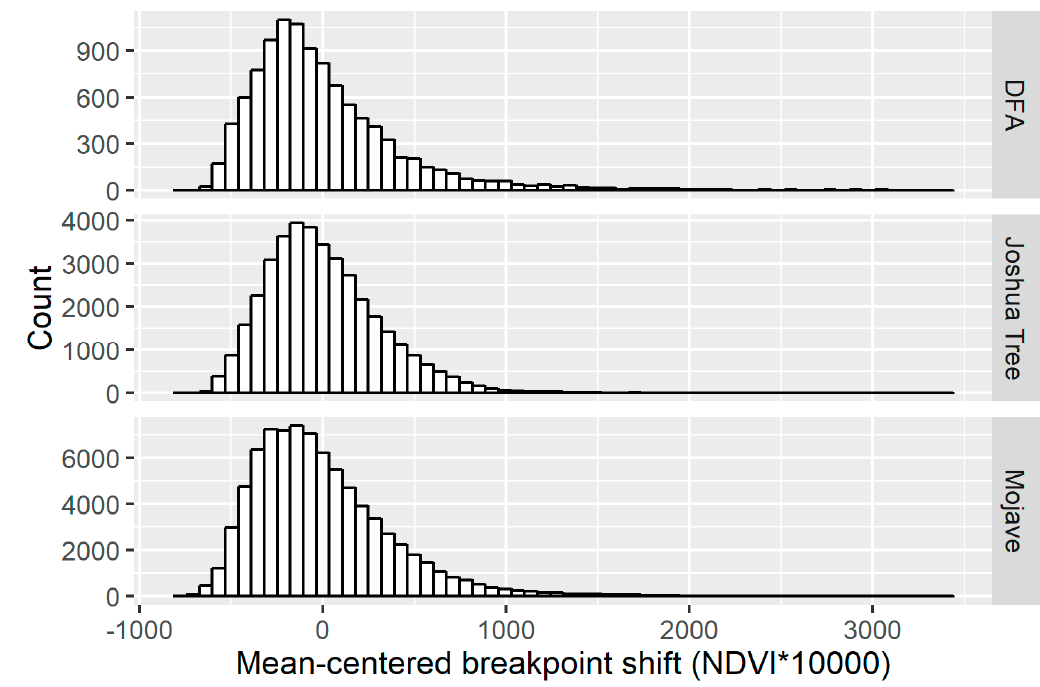
Figure 9. Histograms of breakpoint shifts by site.